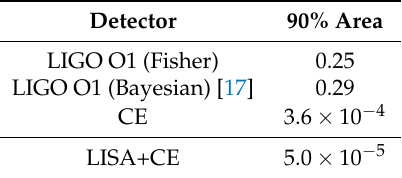
Table 2. Resulting areas of the 90% confidence ellipses from the (cid:101) − σ posterior distributions for GW150914-like events found in Figure 4, as obtained in